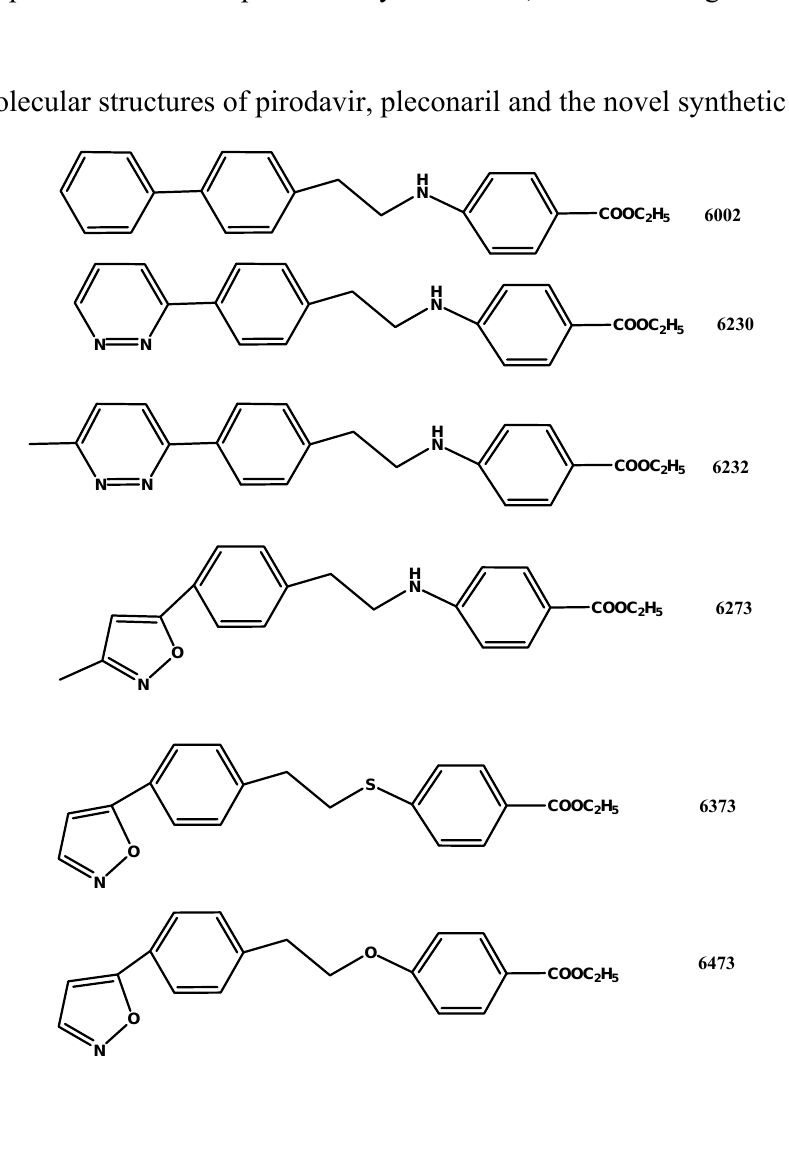
Figure 1. Molecular structures of pirodavir, pleconaril and the novel synthetic compounds.